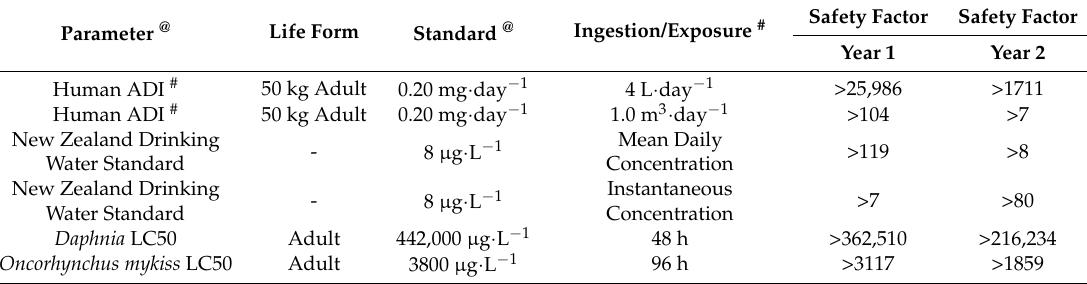
Table 5. Terbuthylazine toxicological parameters and safety